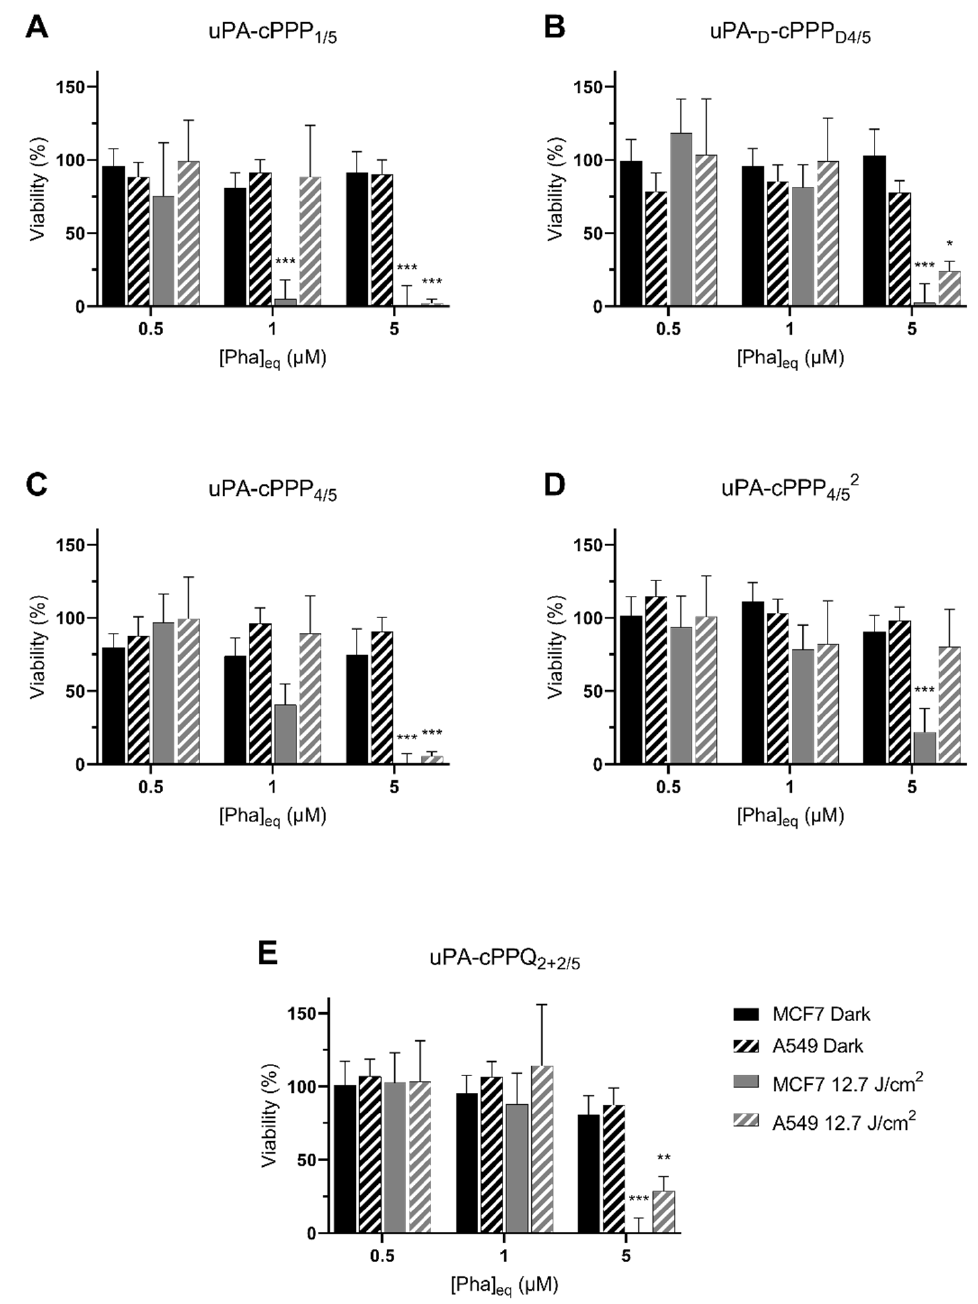
Figure 4. Phototoxicity at 24 h of 0.5 µM, 1 µM or 5 µM Pha eq of ( A ) uPA-cPPP 1/5 , ( B ) uPA- D -cPPP D4/5 , ( C ) uPA-cPPP 4/5 , ( D ) uPA-cPPP 4/52 or ( E ) uPA-cPPQ 2+2/5 in A549 and MCF7 cells kept in the dark or irradiated with 12.7 J/cm 2 of blue light (n = 3; mean ± SD; *: p < 0.05; **: p < 0.01; ***: p < 0.001; two-way ANOVA compared to the dark control at the same concentration of Pha equivalents).